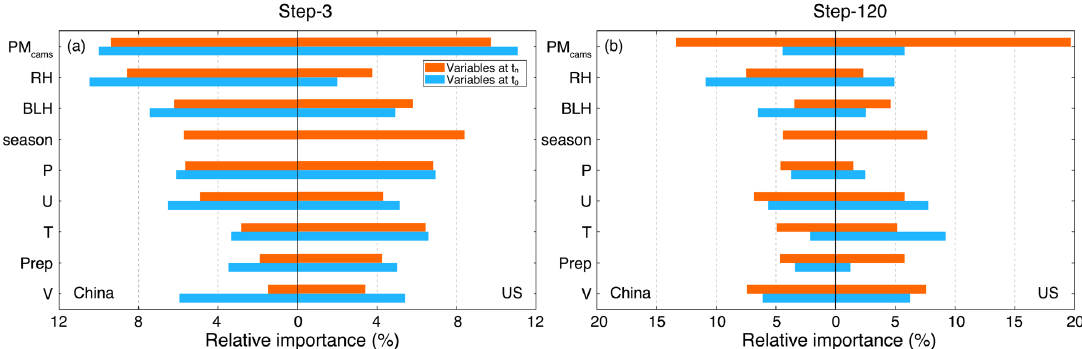
Figure 12. Relative importance of each predictor in the random forest model to calibrate PM 2.5 forecasts at steps 3 ( a ) and 120 ( b ). Variables at t 0 refer to the analyzed predictors while variables at t n are forecasted fields at the n th forecasting